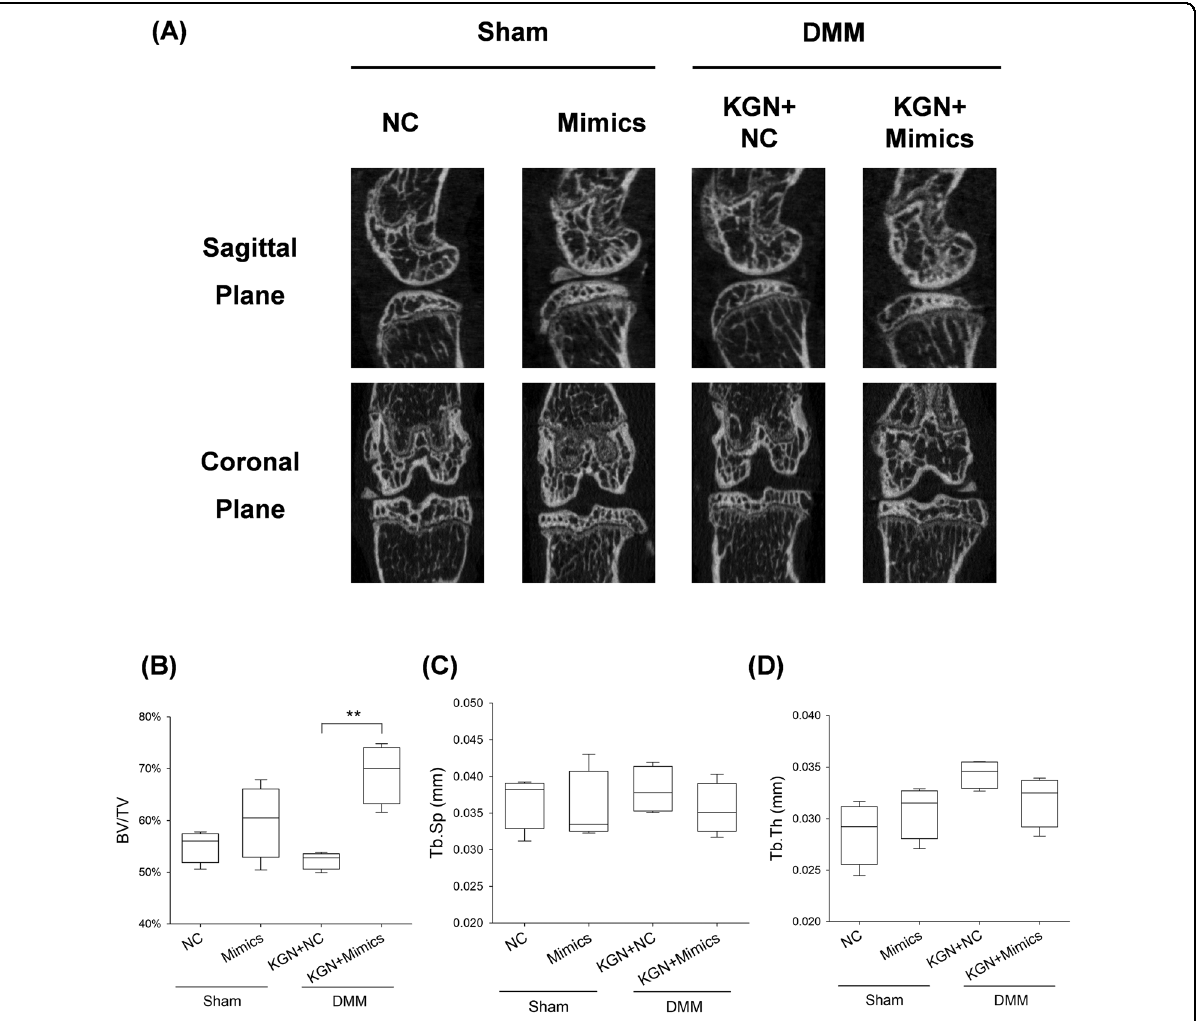
Fig. 8 Effect of up-regulated expression of miR-146a on protective effect of KGN -against subchondral bone sclerosis. A Representative Micro-CT images for medial and coronal planes of femoral condyle and tibial plateau in OA mice. B – D The effects of KGN on subchondral bone parameters including B bone volume ratio (BV/TV, %), C trabecular separation (Tb.Sp., mm), and D trabecular thickness (Tb.Th., mm). Values represent mean ± S.E.M of four replicas. (* p < 0.05 and ** p < 0.01; between the indicated groups and # p < 0.05 or ## p < 0 . 01 versus the CTRL